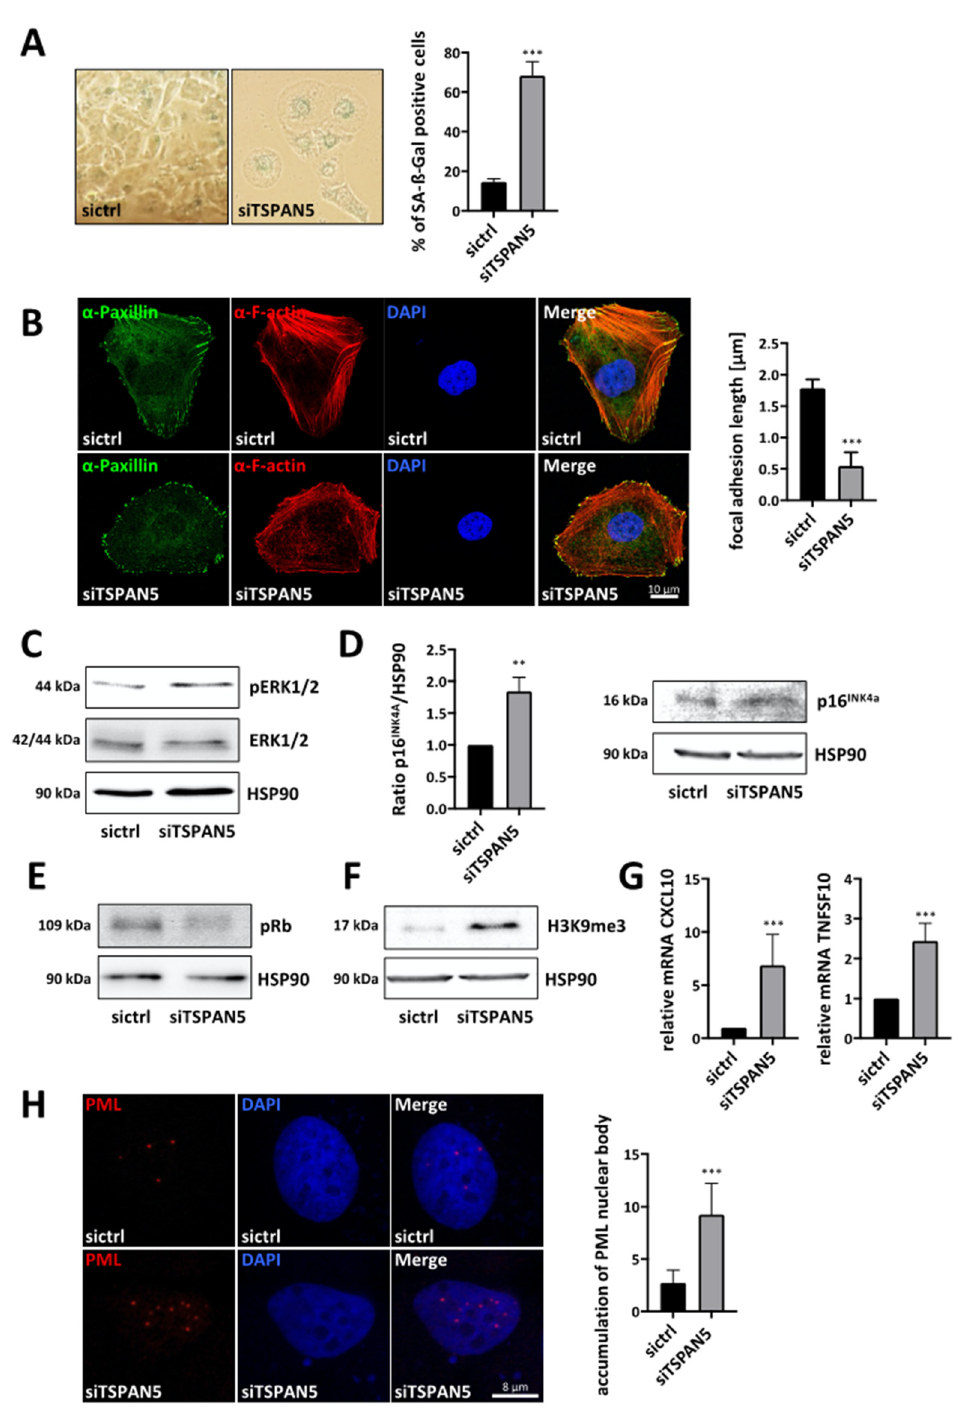
Figure 4. Requirement of TSPAN5 for oncogene-induced senescence. ( A ) Quantification of senescence-associated ß- galactosidase-positive HuH7 cells transiently transfected with control siRNA (sictrl) and TSPAN5 siRNA (siTSPAN5). ß- galactosidase staining was performed 5 days after transfection and ß-gal-positive cells were counted in 100 cells per condition. Data are means ± SD ( n = 3); ***, p < 0.001. ( B ) Immunofluorescence analysis of focal adhesions with α -paxillin staining and F-actin staining with phalloidin in HuH7 cells transfected with TSPAN5 siRNA (siTSPAN5) or negative control siRNA (sictrl). DAPI was used for nuclei staining. The focal adhesion length was measured manually in 50 cells in each of the 5 randomly selected fields by using the ImageJ software in three independent experiments. Scale bar, 10 µm. Data are means ± SD ( n = 3); ***, p < 0.001. ( C – F ) Lysates of HuH7 cells transiently transfected with negative control siRNA (sictrl) or TSPAN5 siRNA (siTSPAN5) for 6 days were immunoblotted with anti-pERK1/2 and anti-ERK ( C ), anti-p16 INK4a (quantitation on the left) ( D ), anti-pRb ( E ) and anti-H3K9me3 antibodies ( F ). HSP90 was used as a loading control and